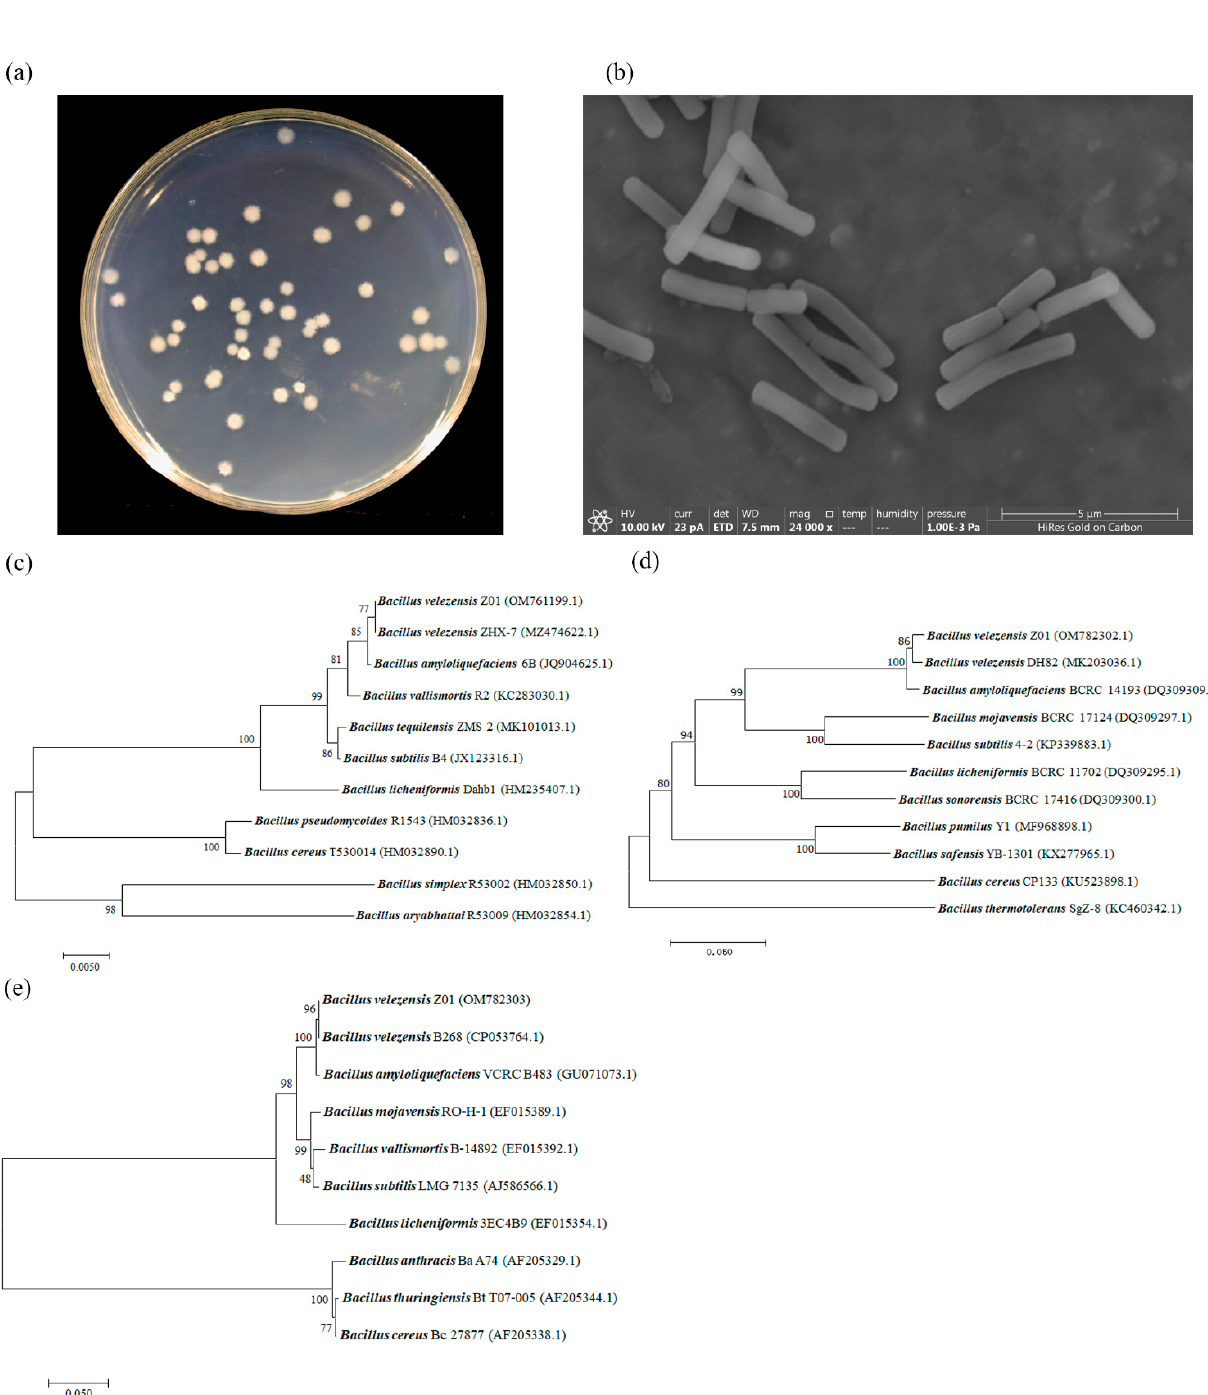
Figure 1. Taxonomic identification of marine microorganism Z01. ( a ) The colony of B. velezensis Z01 cultured on a Luria-Bertani plate. ( b ) The B. velezensis Z01 was observed under the scanning electron microscope (SEM) with a magnification of 24,000 × . Phylogenetic relationships of B. velezensis Z01 based on ( c ) partial 16S rDNA sequences, ( d ) gyrB and ( e ) rpoB . Based on the biochemical properties, strain Z01 was preliminarily identified as the Bacillus genus (Supplementary Table S1). Moreover, in terms of 16S partial rDNA (Gen- Bank No. OM761199, 1447 bp), gyrB (GenBank No. OM782302, 1160 bp) and rpoB (Gen- Bank No. OM782303, 556 bp) sequences of strain Z01 exhibited similarities with those of Bacillus velezensis according to the Nucleotide BLAST program and neighbor-joining